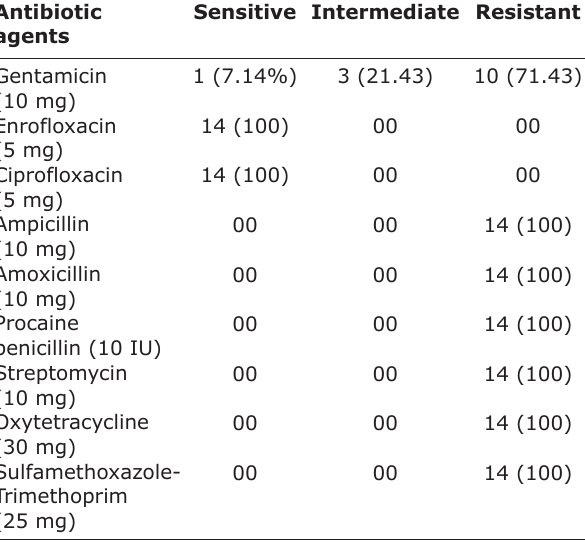
Table-3: Numbers and percentages (%) of sensitive, intermediate, and resistant Escherichia coli strains isolated from bovine mastitis against common antibiotic agents